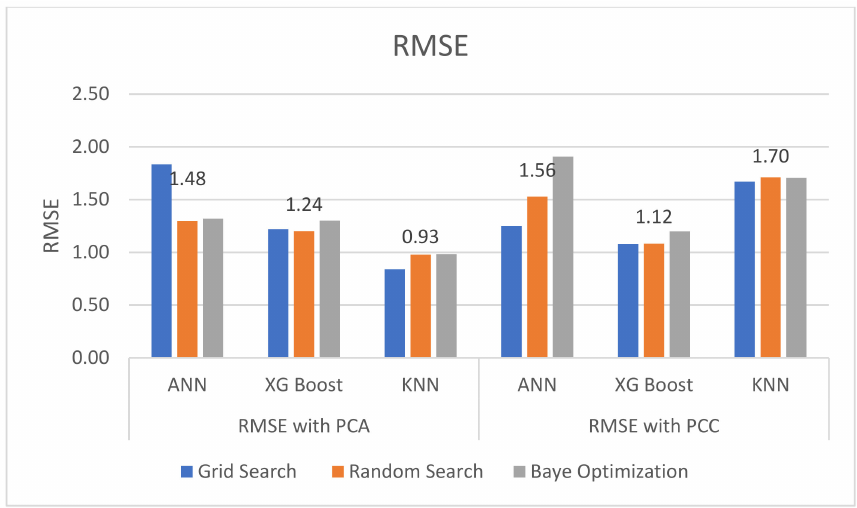
Figure 17. RMSEs Obtained from Each Model with PCA and